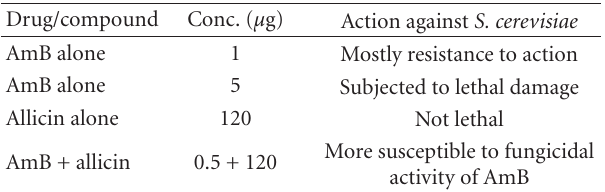
Table 25: Enhancement of fungicidal activity of AmB by Allicin against S. cerevisiae